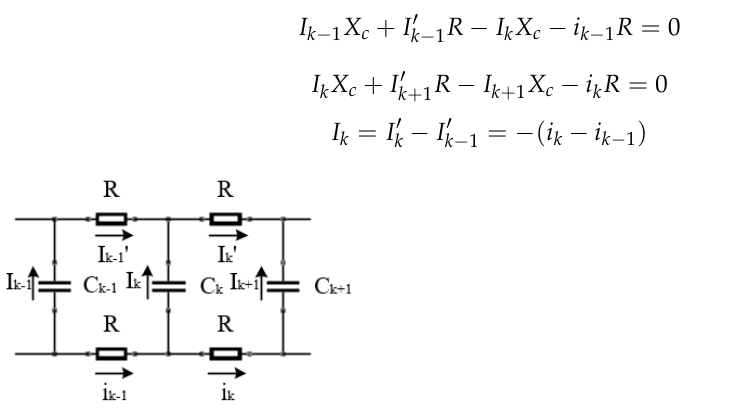
Figure 4. Network